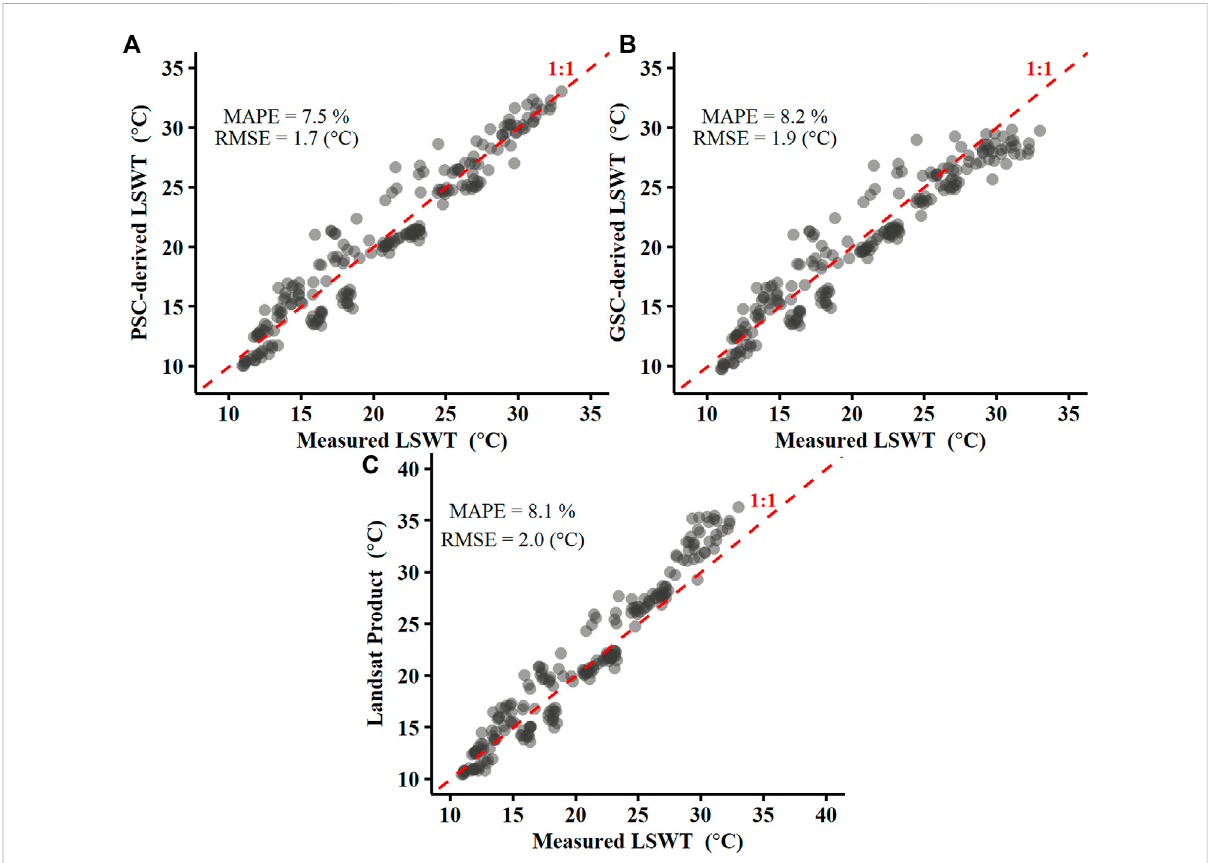
FIGURE 2 Validation results of Landsat-based LSWT data derived from the PSC algorithm (A) , GSC algorithm (B) and Landsat land surface temperature product (C) .